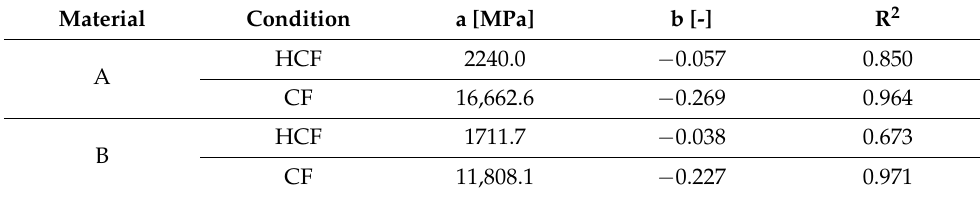
Table 2. Coefficients obtained from the regression analysis of the fatigue tests.